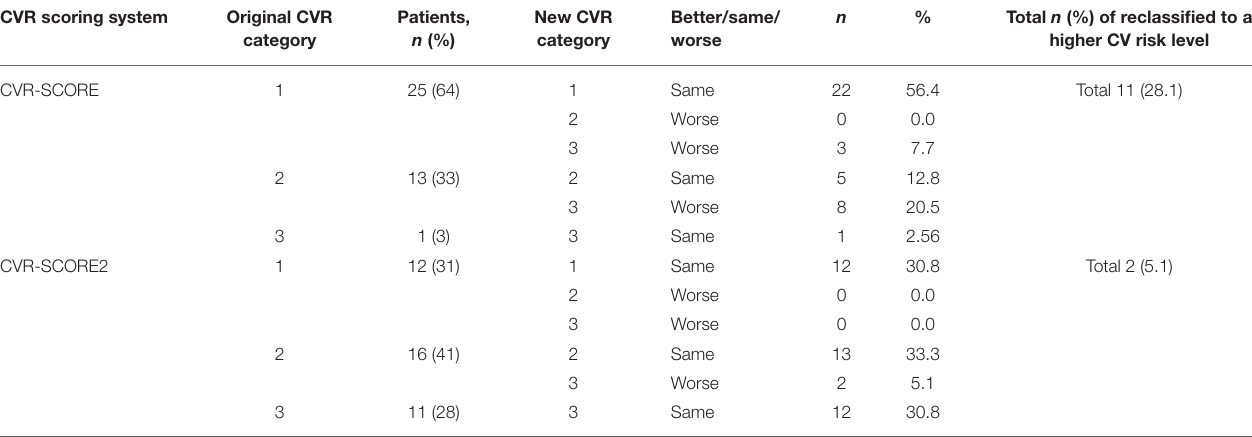
TABLE 7 | Reclassification of the original cardiovascular risk category in HC based on SCORE, SCORE2, and mSCORE to the cardiovascular risk category based subclinical atherosclerosis markers on carotid ultrasound examination. CVR scoring